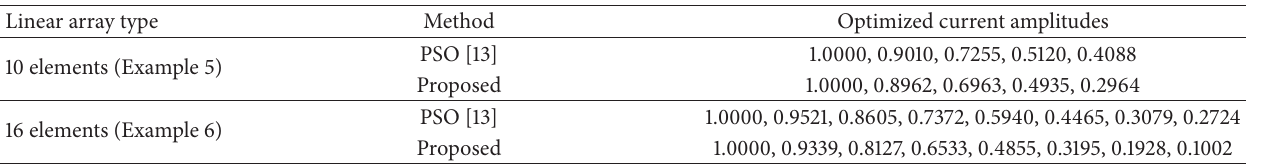
Table 10: Optimized current amplitudes for peak SLL minimization.